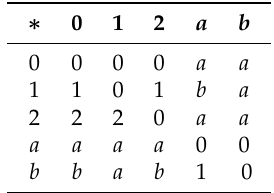
Table 1. Cayley table of the operation ∗ .